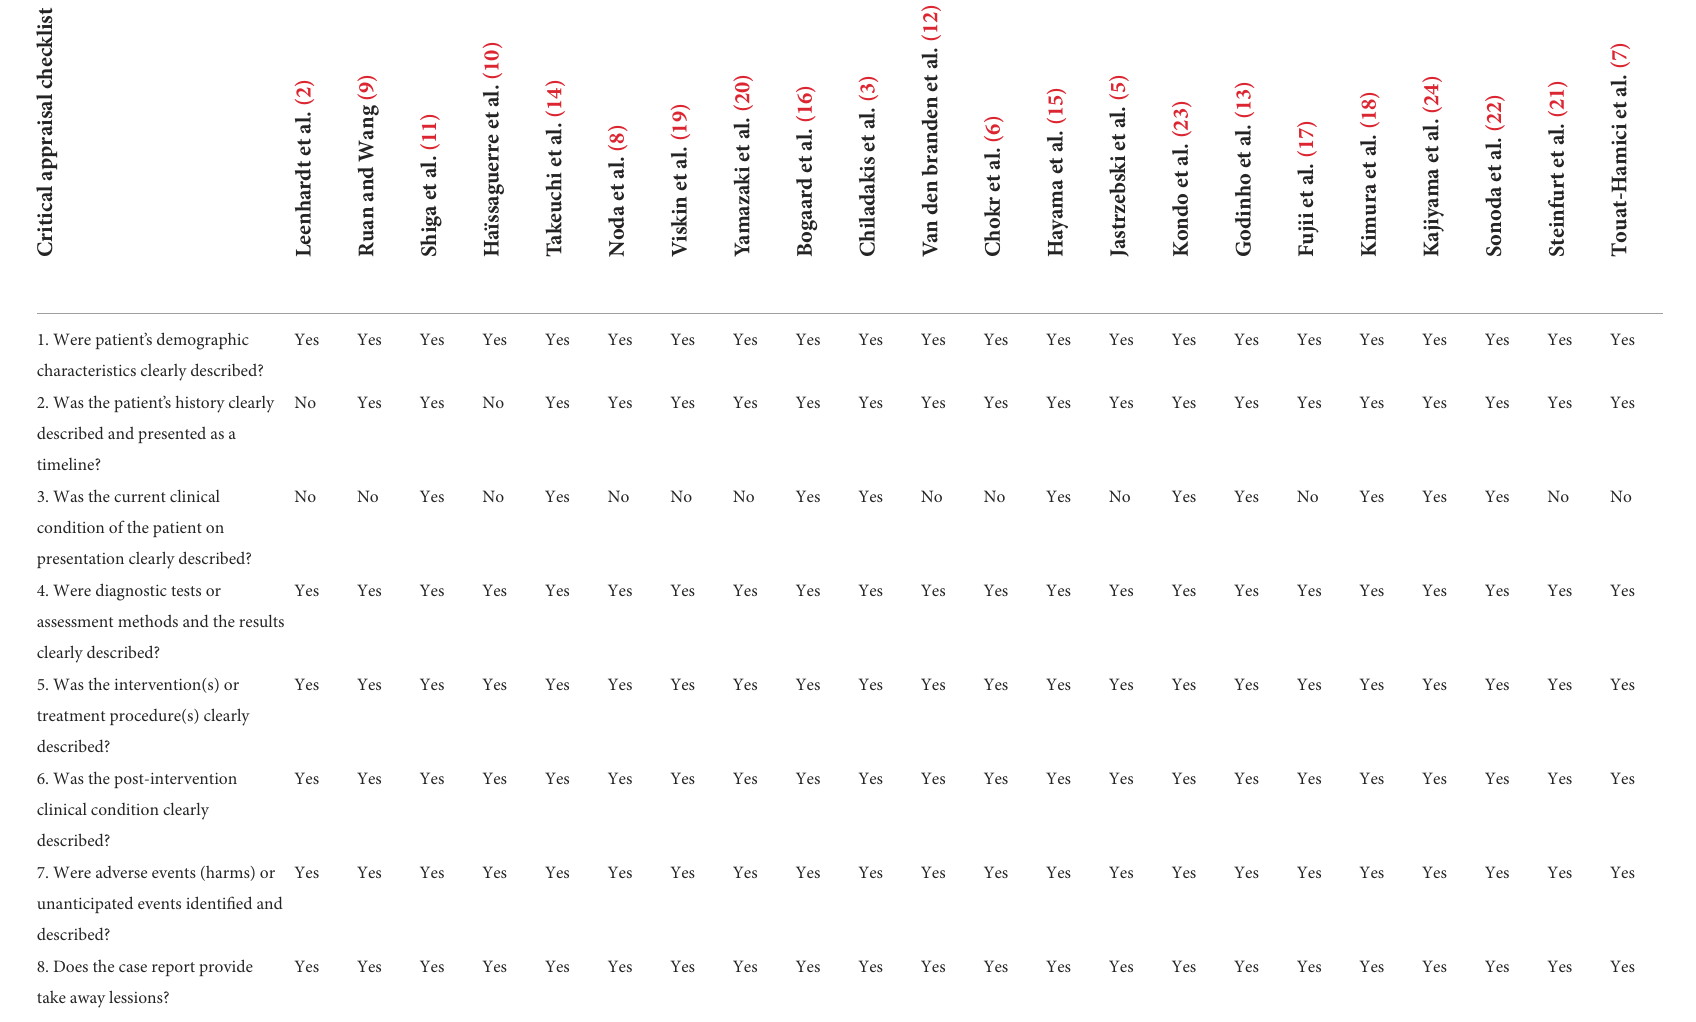
TABLE 2 Critical appraisal checklist for case reports included in this